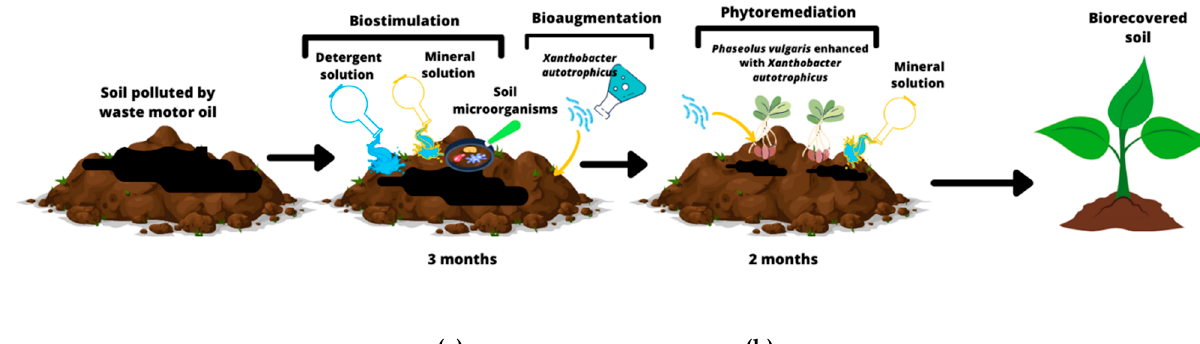
Figure 3. Bioremediation of soil impacted by waste motor oil, ( a ) biostimulation: induces min- eralization of WMO by soil microorganisms/ bioaugmentation: increase WMO mineralization, ( b ) phytoremediation: end of the elimination of remaining